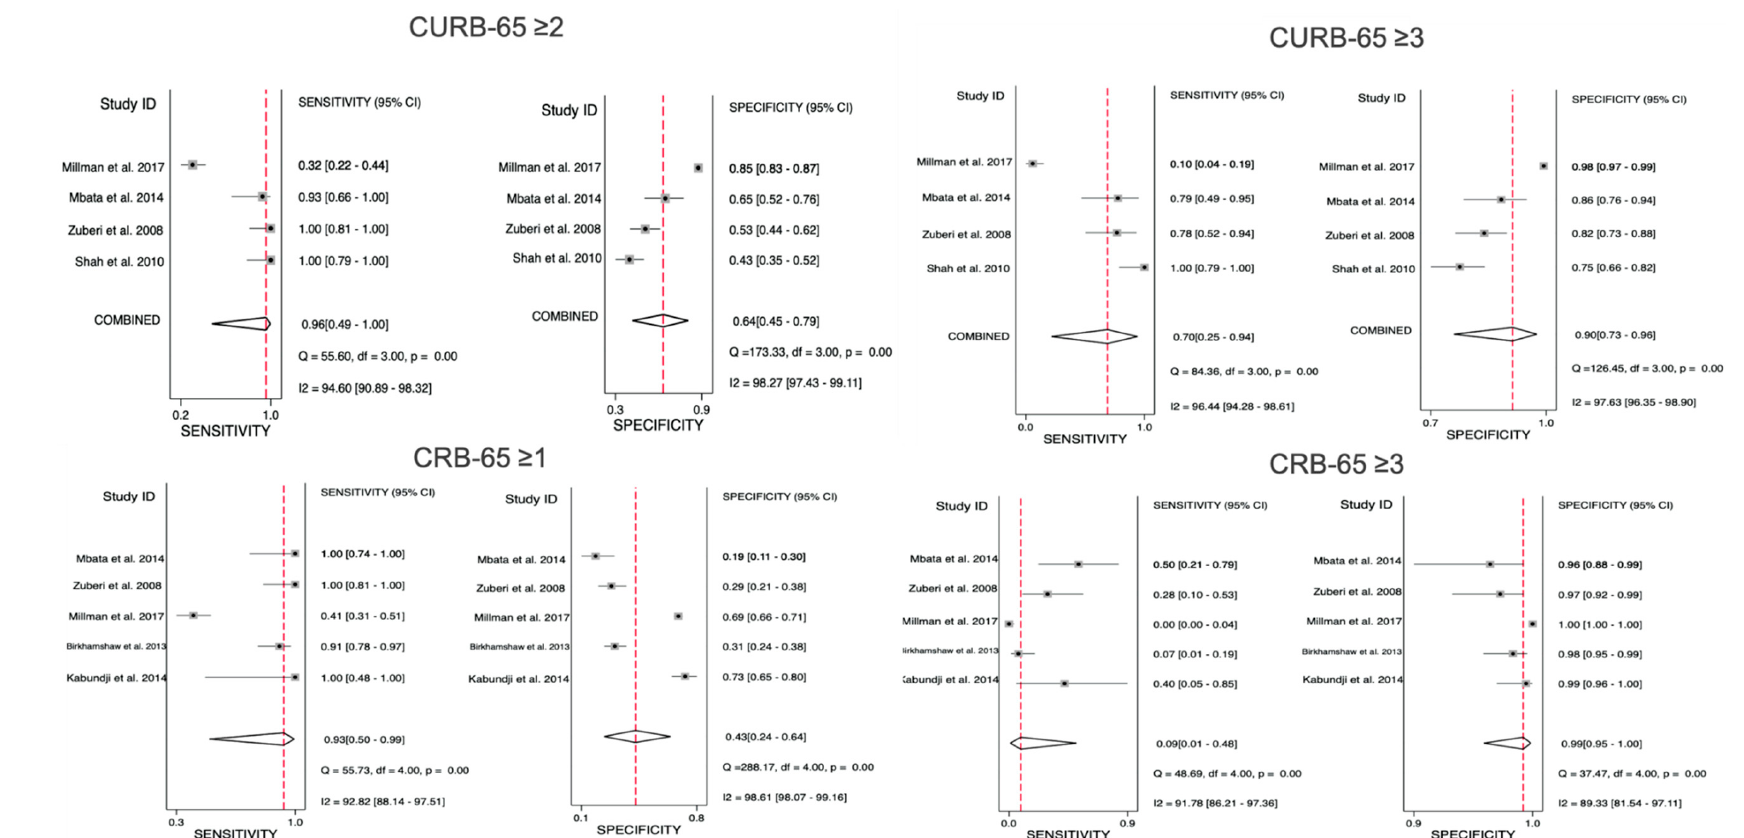
Figure 3 . Forest plots for the sensitivity and specificity of CURB-65 and CRB-65 at the studied cut-offs for mortality prediction.